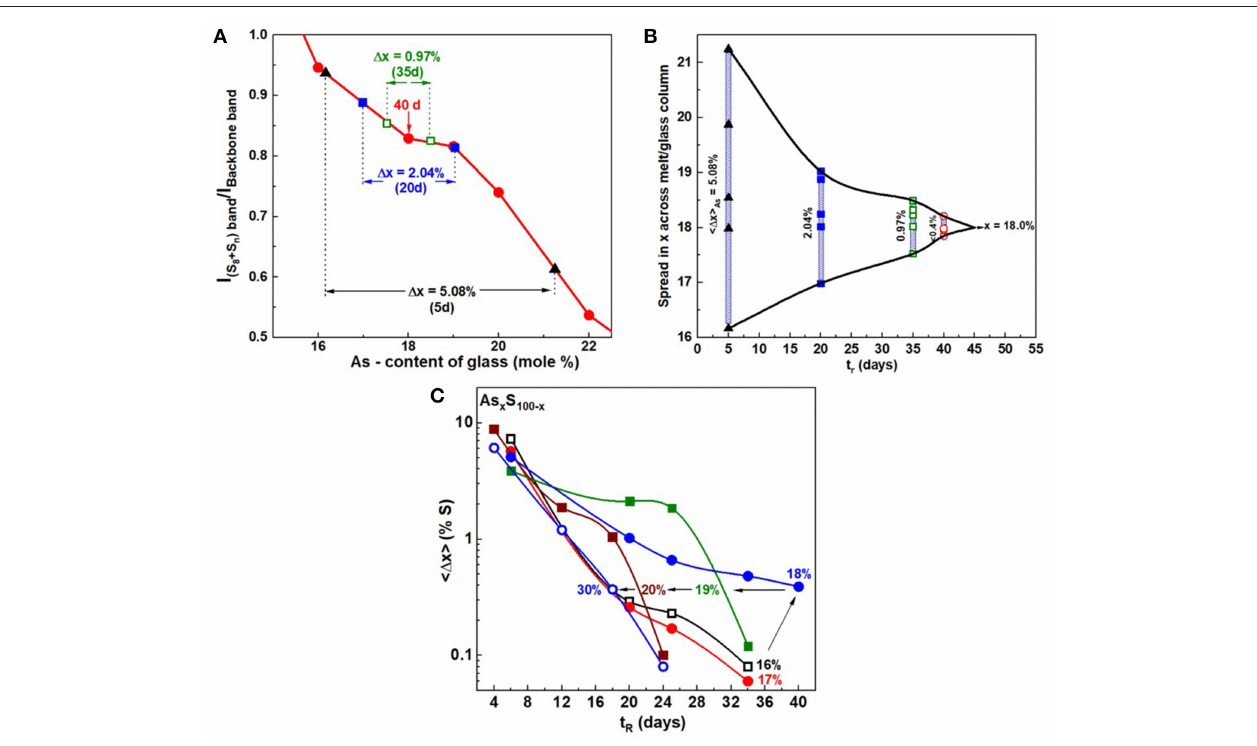
FIGURE 6 | (A) Observed variation in the ratio of the scattering strength of S—related band near 472 cm − 1 to the backbone band near 340 cm − 1 plotted against the As content of glasses. The red data points are results obtained on fully homogenized glasses from x = 16% to x = 22%, with the smooth red curve serving as an empirical curve. Superposed on the calibration plot are the results obtained for a glass sample weighed at x = 18% as it was alloyed from 5 to 40d, and the variance in S—concentration to narrow from 5.08% to about 0.4%. In (B) the narrowing data of the S—variance, taken to be the same as the As—variance, is plotted as a function of alloying time, t r , in days for As 18 S 82 glass. It provides a pictorial view of the manner in which the weighed glass at x = 18% undergoes delayed homogenization. In (C) we provide a global view how the S-variance of the batches decreases with alloying time t r in days at different As content x. Note that at x = 18%, the kinetics are slowest, and these decrease both at low x ( < 18%) and high x ( > 18%). The x = 18% composition also is the one where the QT fraction is the highest. See Supplementary Information